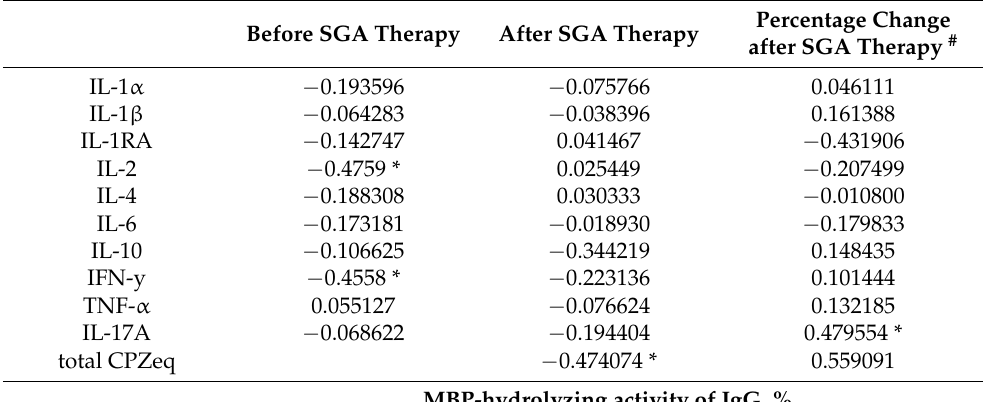
Table 4. Spearman’s correlation analysis of the cytokine levels and MBP-hydrolyzing activity of IgG before and after SGA